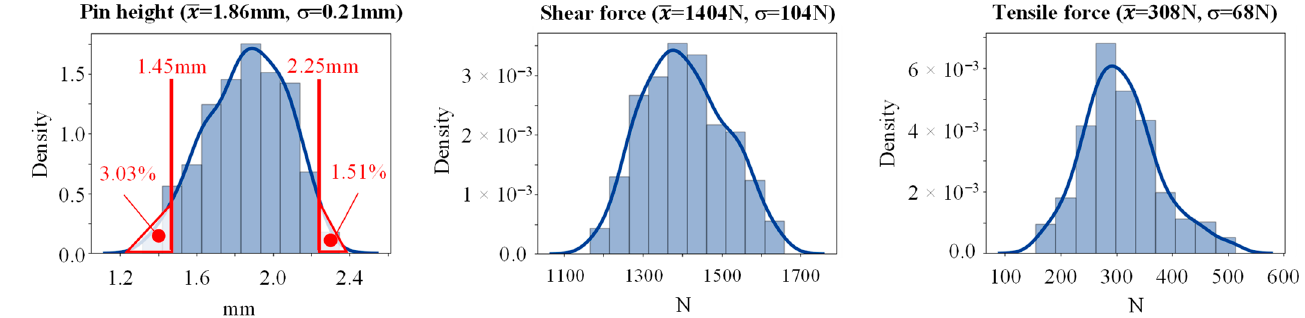
Figure 13. Property distribution of pin joint characteristics based on the second robustness analysis.